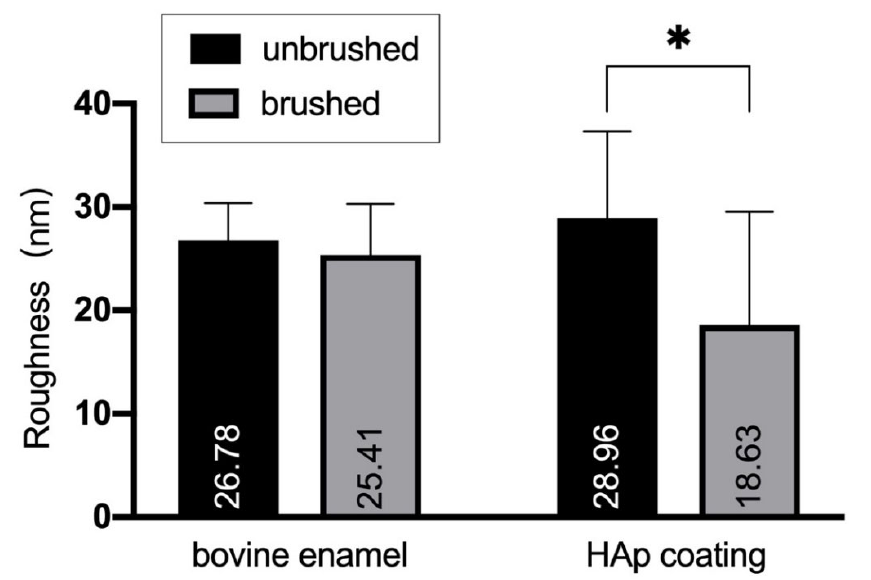
Figure 6. Roughness values of the specimen with and without hydroxyapatite coating before and after the brushing test ( n = 10). * p < 0.05 .